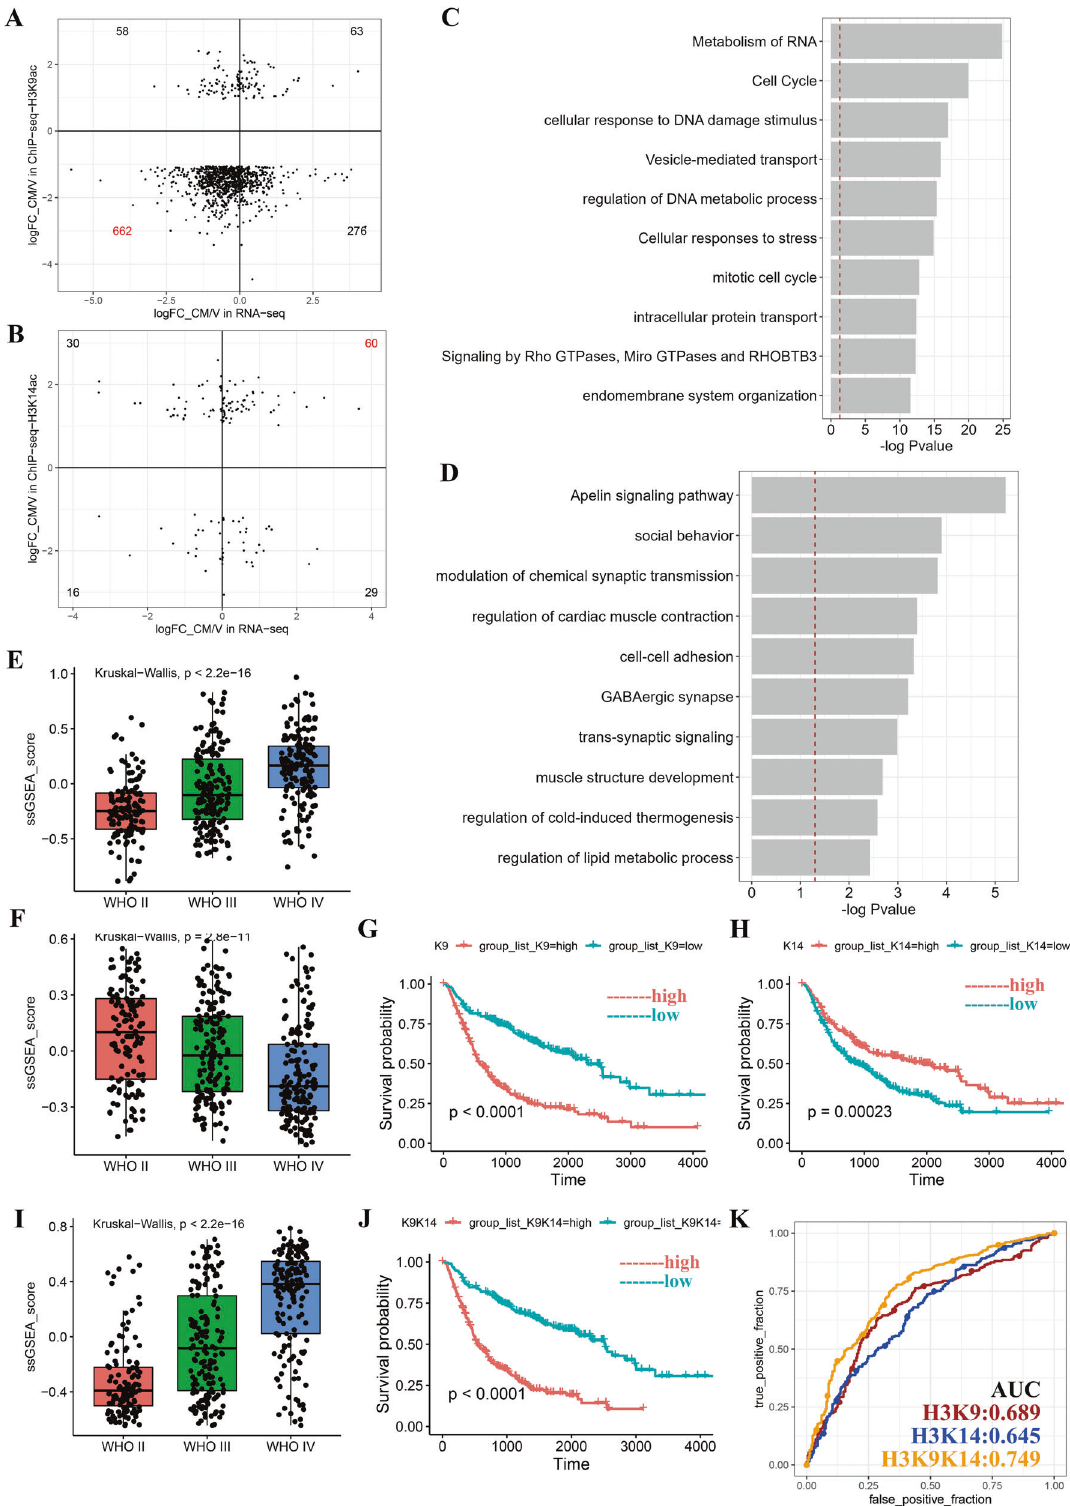
regulation, further supporting the judgment of neuron-like phenotype transformation (Fig. 6F, G). Furthermore, via ChIP-seq analysis, we also observed the decrease in H3K9ac tags of cell- proliferation genes and the increase in H3K9ac/H3K14ac tags of the neuron-related genes in GSC-11 cells (Fig. 6H), in agreement with U87MG. In addition, H3K27ac also exhibits very